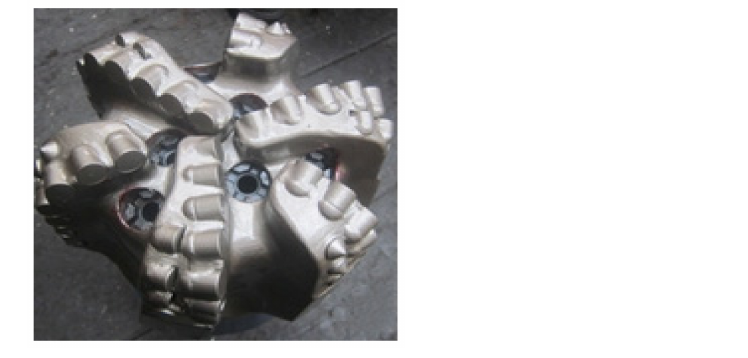
Figure 4. The PDC bit used in the Lufeng X well with a composite